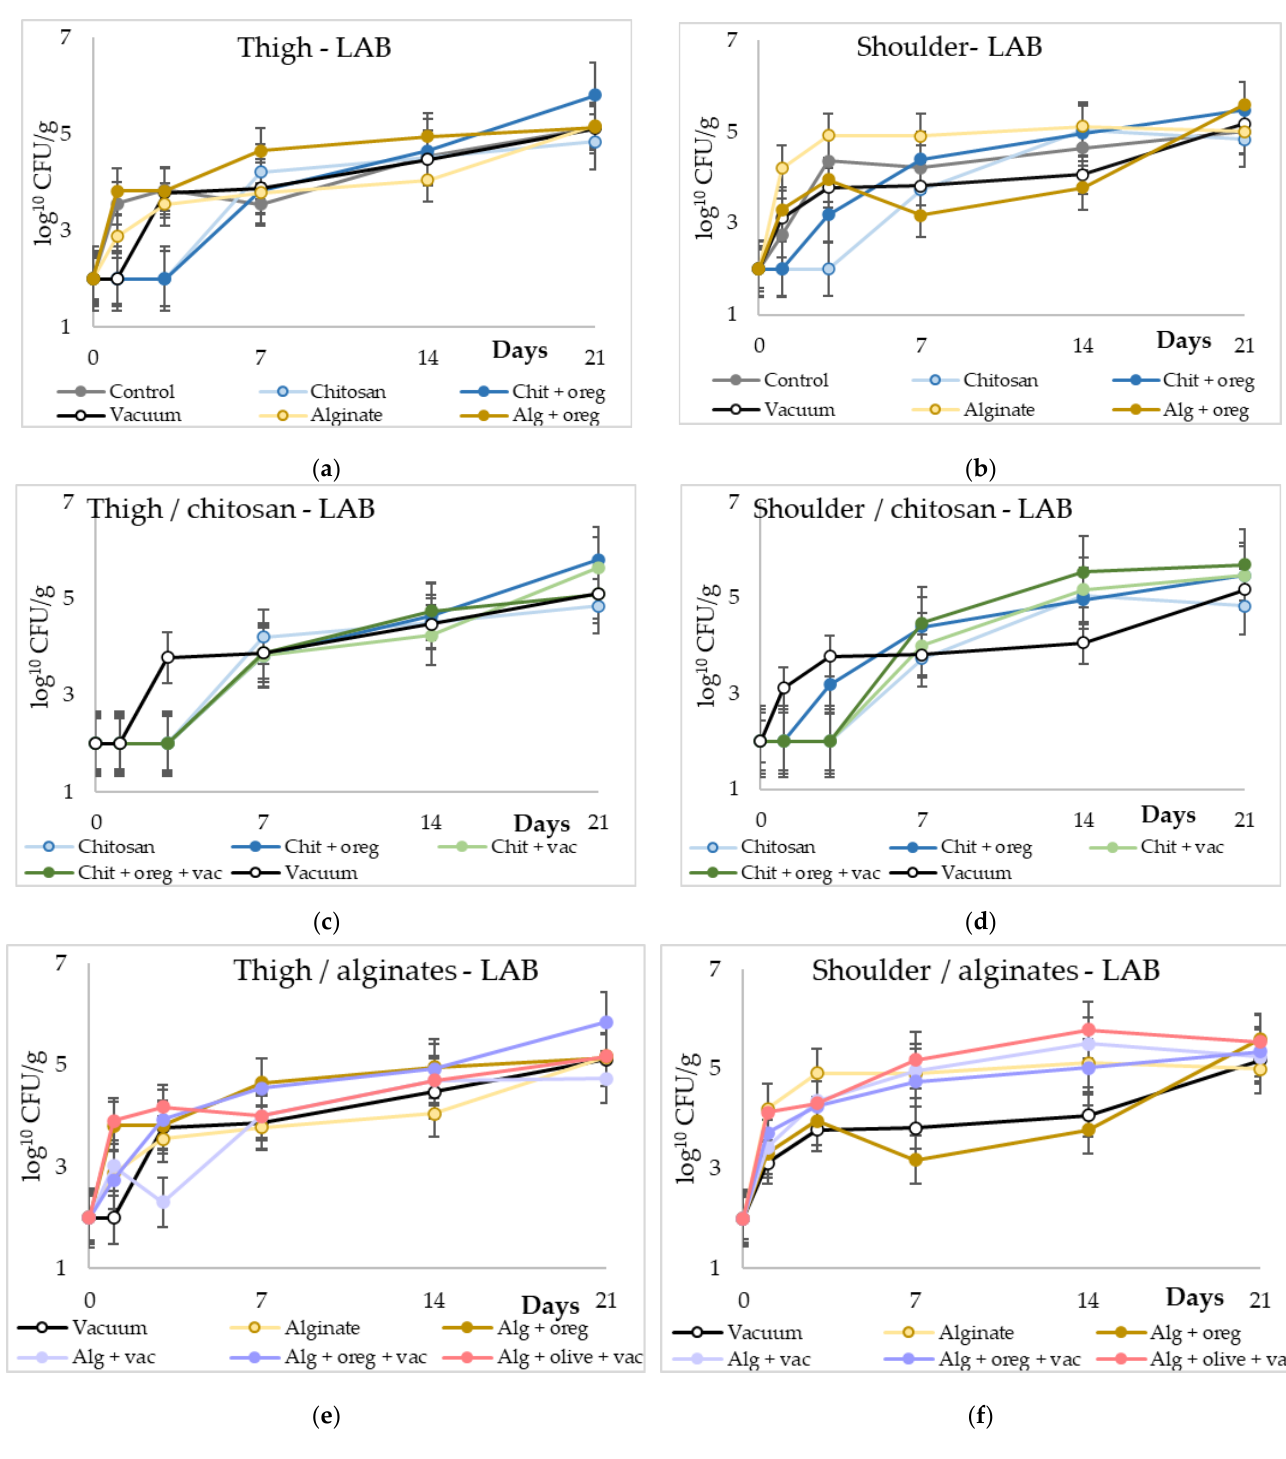
Figure 4. Populations of lactic acid bacteria (log 10 cfu/g) in meat pieces over time (days). ( a , b ) LAB of control against chitosan or alginate coating with or without vacuum packaging in thigh and shoulder pieces; ( c , d ) LAB of different chitosan treatments in thigh and shoulder pieces; ( e , f ) LAB of different alginate treatments in thigh and shoulder pieces. (Chit: chitosan coating; oreg: oregano essential oil; vac: vacuum packaging; Alg: alginate coating; olive: olive oil addition). A similar trend was observed in the populations of B. thermosphacta . Over time, an increase in its population was observed in all experimental groups. Meat pieces with chi- tosan coating stored aerobically or under vacuum, as well as meat pieces coated with chi- tosan and oregano oil and stored under vacuum, had significantly lower ( p -value < 0.05)